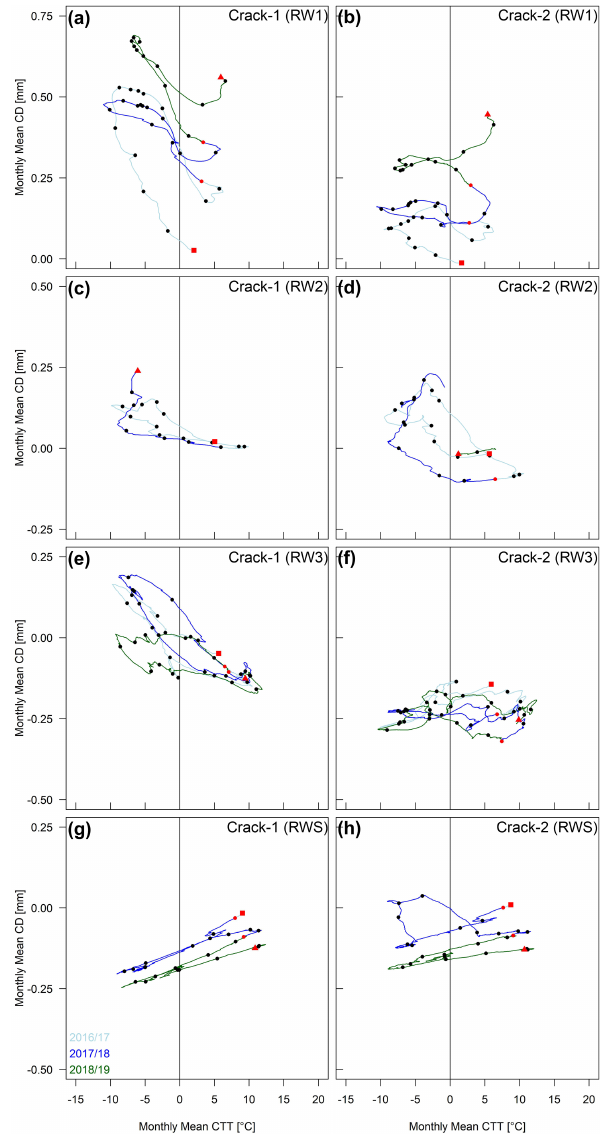
Figure 7. Monthly mean crack deformation plotted versus monthly mean crack-top temperature for individual crackmeters. Red rectan- gles indicate the start, black dots the first day of a month, red dots the beginning of the new measurement period and red triangles the end of measurements. Colours of graphs indicate data from 2016/17 (light blue), 2017/18 (blue) and 2018/19